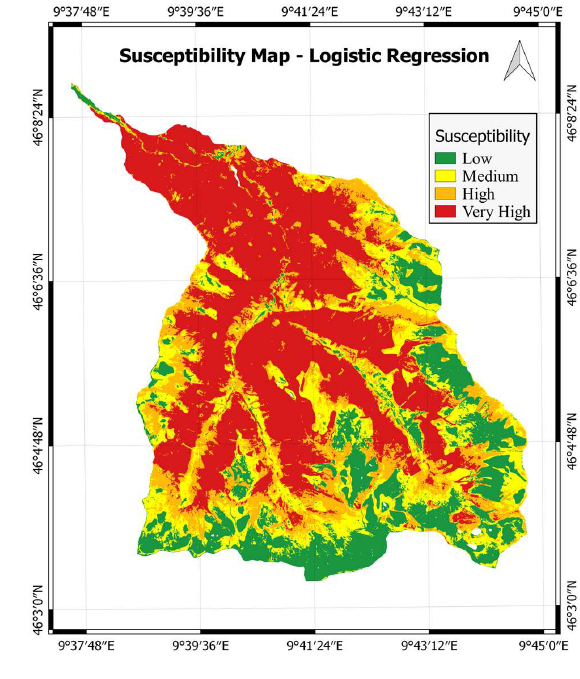
Figure 4. Susceptibility map produced with Logistic Regression